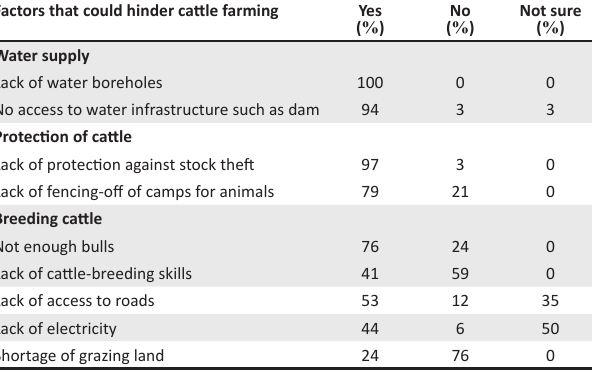
FIGURE 1: Existing skill levels related to cattle